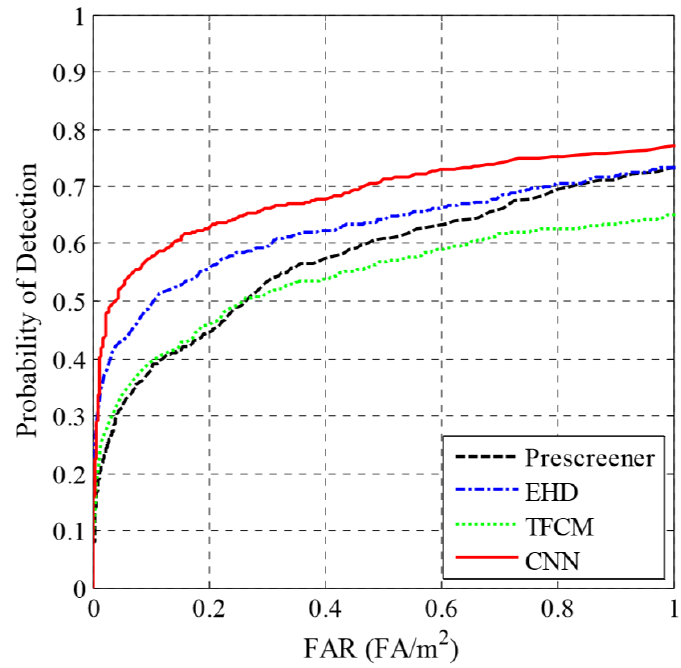
Figure 12. ROC curves summarizing the performance of our anomaly detection and discrimination